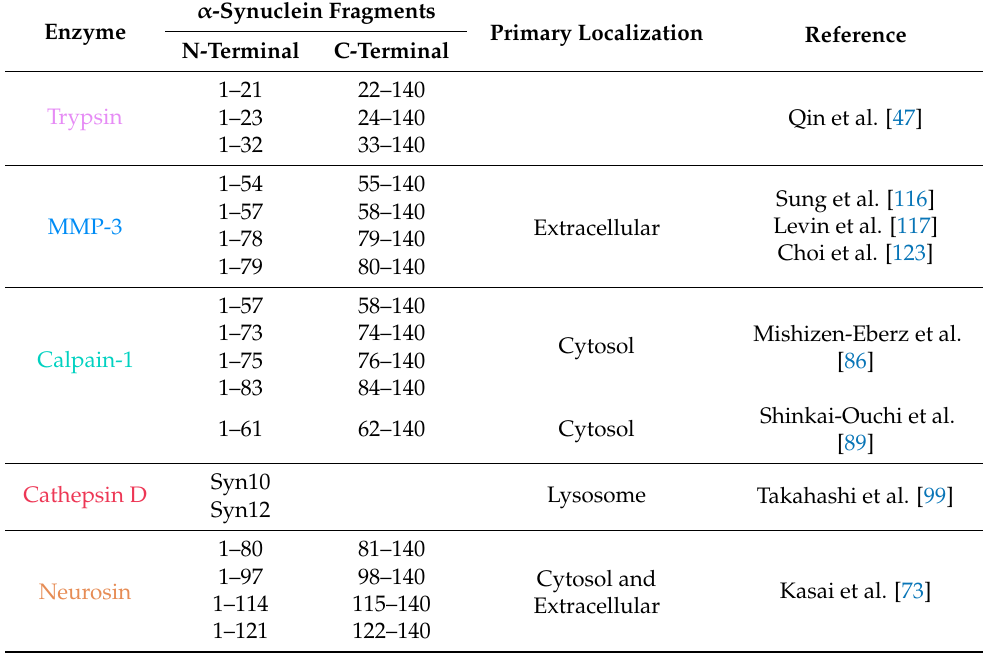
Table 1. α -Synuclein cleavage sites, localization, and references to